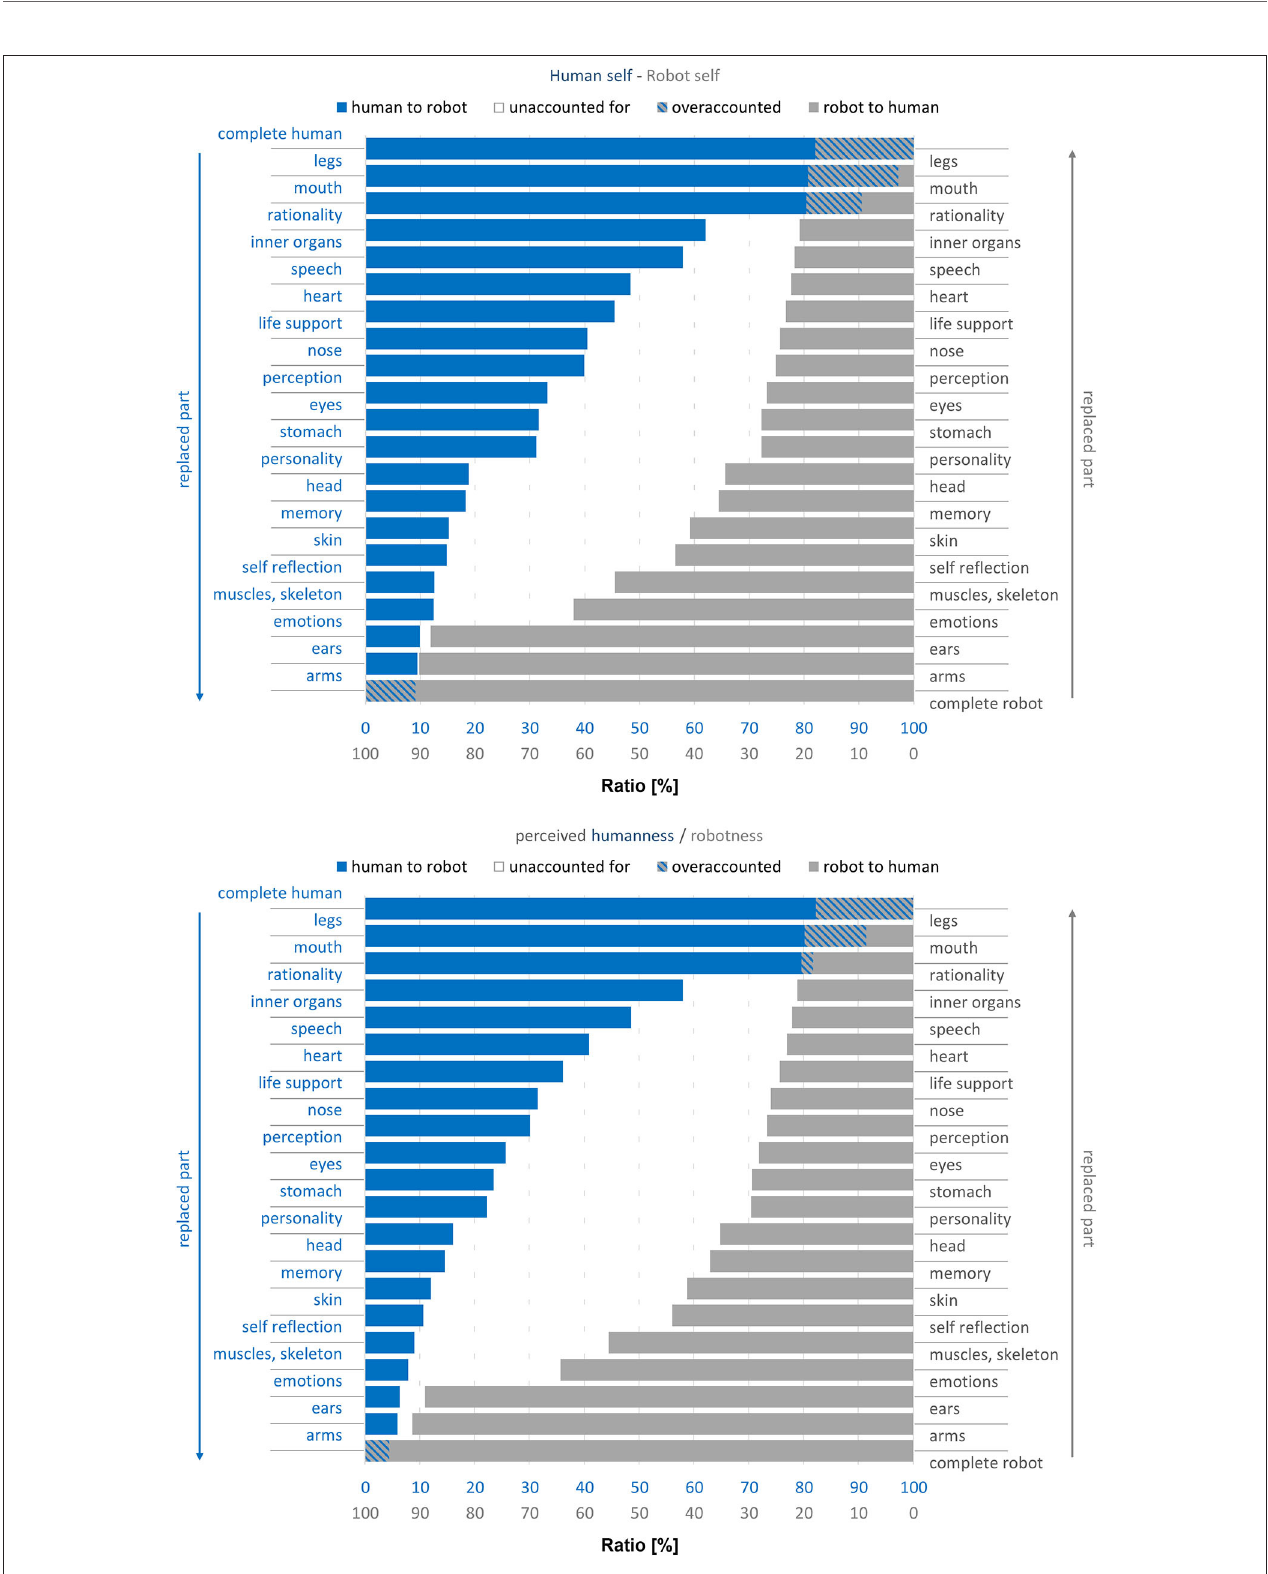
FIGURE 3 | Combined findings of the two experimental conditions for ratings of remaining self (top) and remaining humanness vs. robotness (bottom).